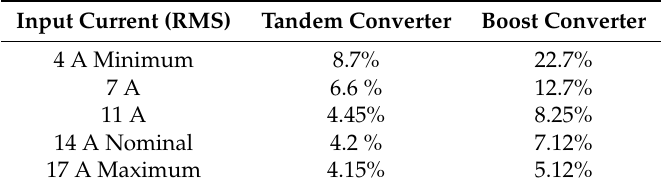
Table 2. THD analysis of the tandem and boost